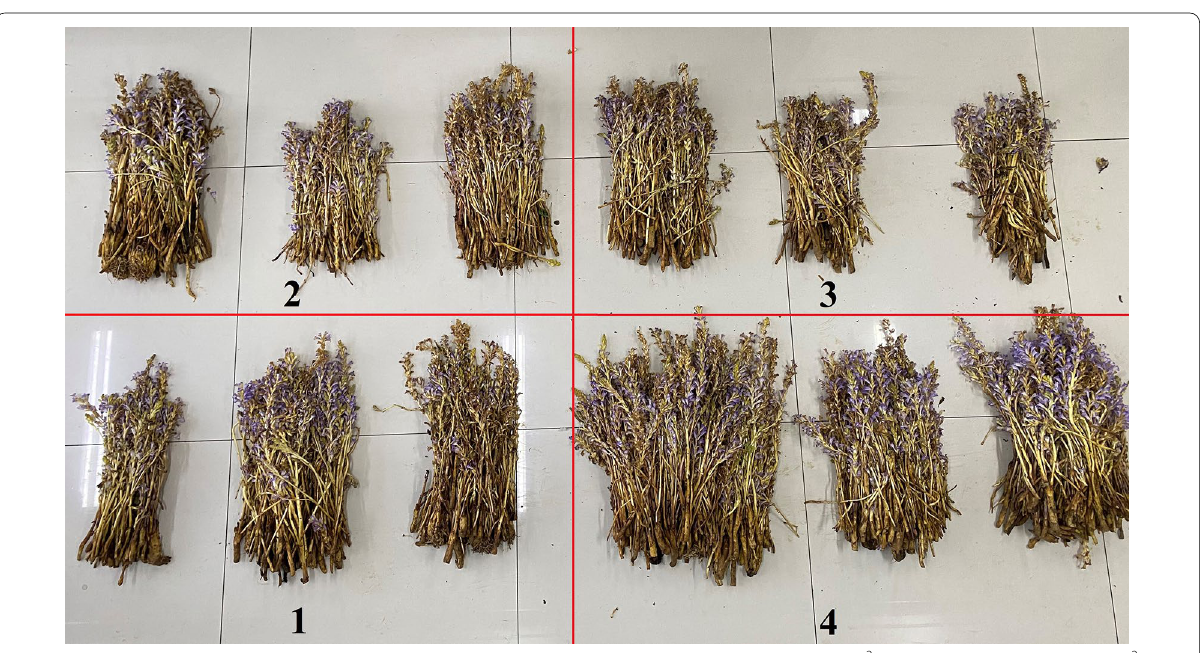
Fig. 1 The Egyptian broomrape number of different treatments in the field. 1 was JTB8–2 agent 0.8 L/105m 2 ; 2 was JTB8–2 agent 1.6 L/105m 2 ; 3 was JTB8–2 agent 3.2 L/105m 2 ; 4 was blank